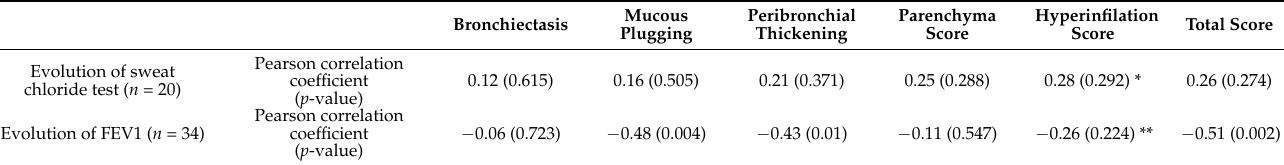
Table 2. Correlations between changes in sweat test, FEV1, and Brody’s scores. Bronchiectasis Mucous Plugging Peribronchial Thickening Parenchyma Score